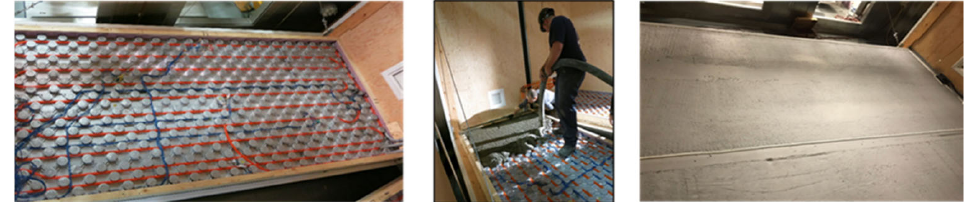
Figure 2. Radiant floor piping before ( left ), during ( middle ), and after ( right ) pouring the concrete. A mechanical room provides controlled flow rate of the fluid (propylene-glycol and water mixture) for the radiant floor. The schematic of the environmental chamber and PZTC is shown in Figure 3.